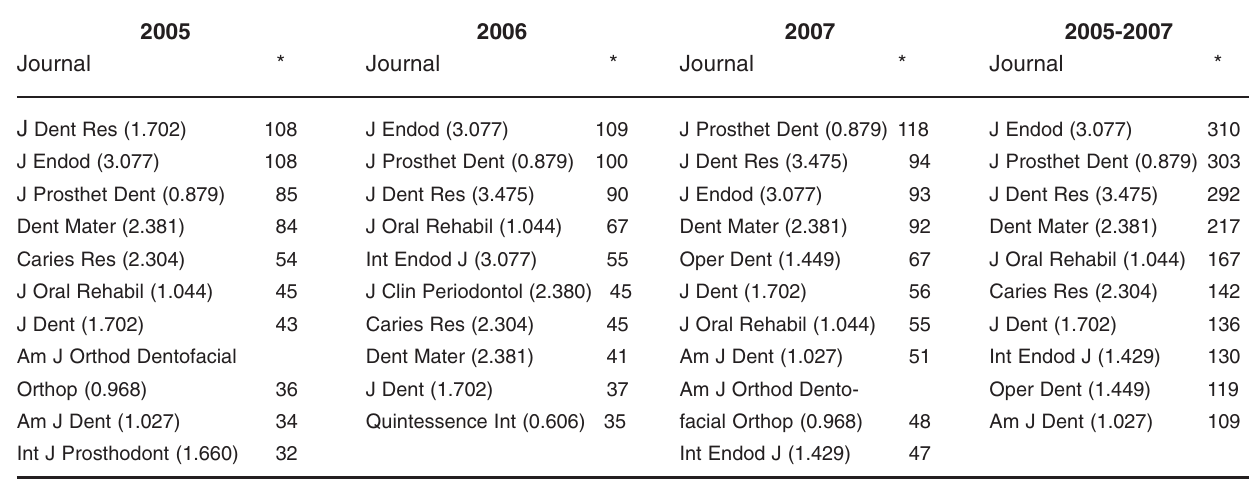
*Number of citations of the journal. ( ) Impact Factor.